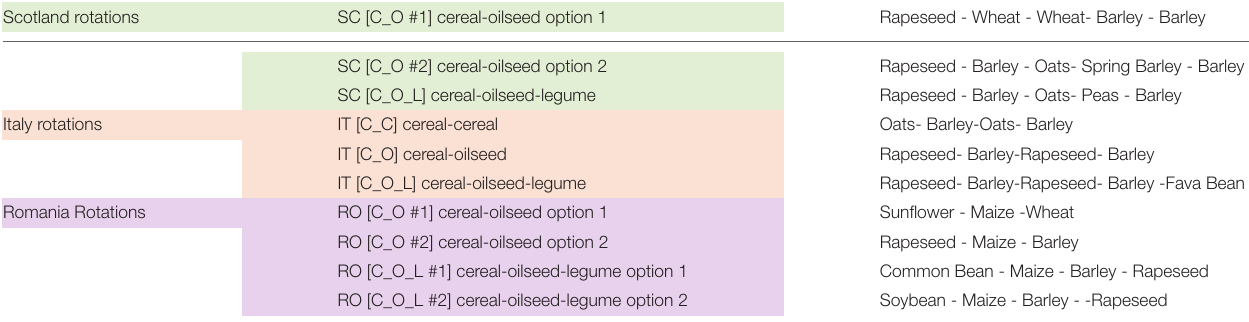
TABLE 1 | Crop sequences of each rotation in Scotland (SC), Italy (IT), and Romania (RO). Scotland